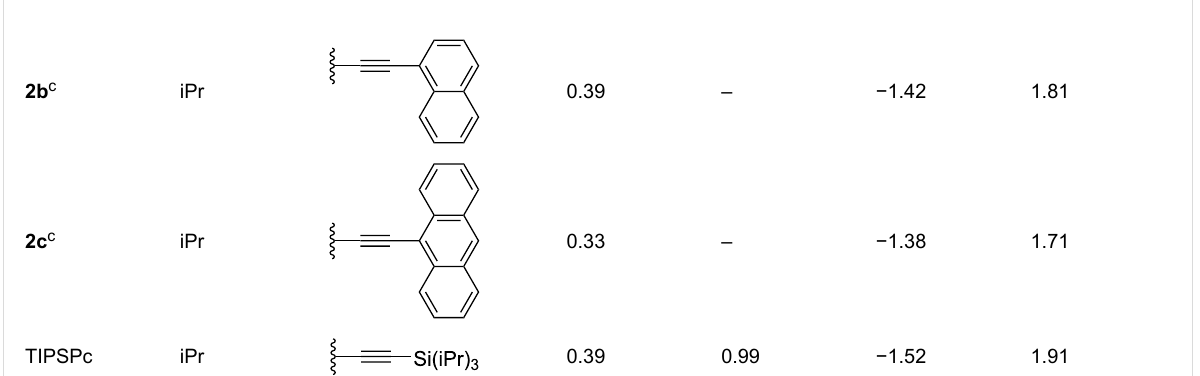
Table 3: Electrochemical properties of 3a – k compared to TIPSPc and 2a – c . a (continued)